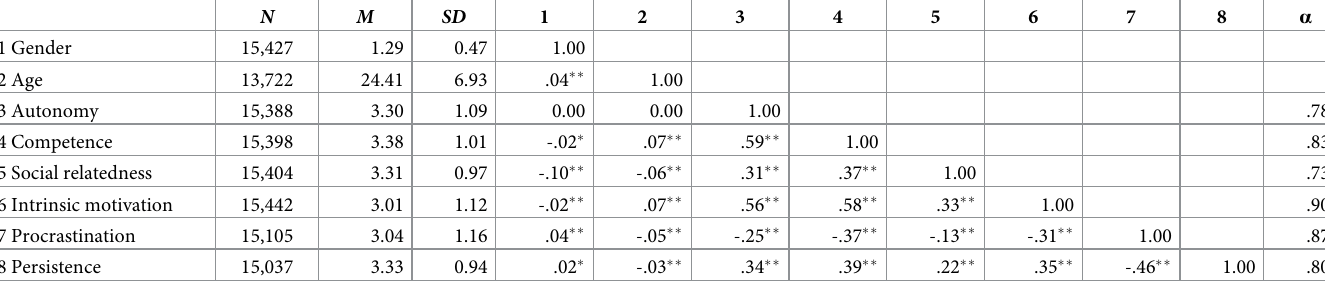
Table 2. Descriptive statistics, correlations, and scale reliabilities (overall